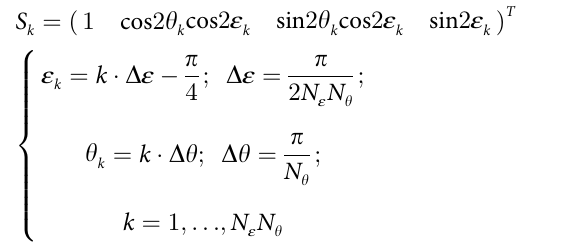
PLOS ONE | https://doi.org/10.1371/journal.pone.0213909 March 14,